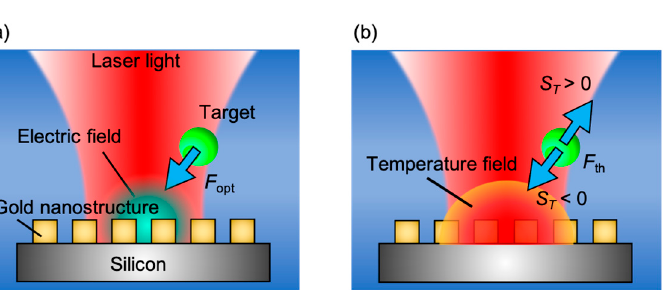
Figure 1. Schematic of manipulation of nanomaterials by ( a ) plasmon optical tweezers and ( b ) thermophoresis, induced around gold nanostructures. An optical force ( F opt ) acts on the target nanomaterials due to LSPR. When the heat generationis is predominant, by theremophoretic force ( F th ) moves nanomaterials away from the hot region when Soret coefficient is positive ( S T > 0) whereas target materials migrate toward the hot region when Soret coefficient is negative ( S T < 0).